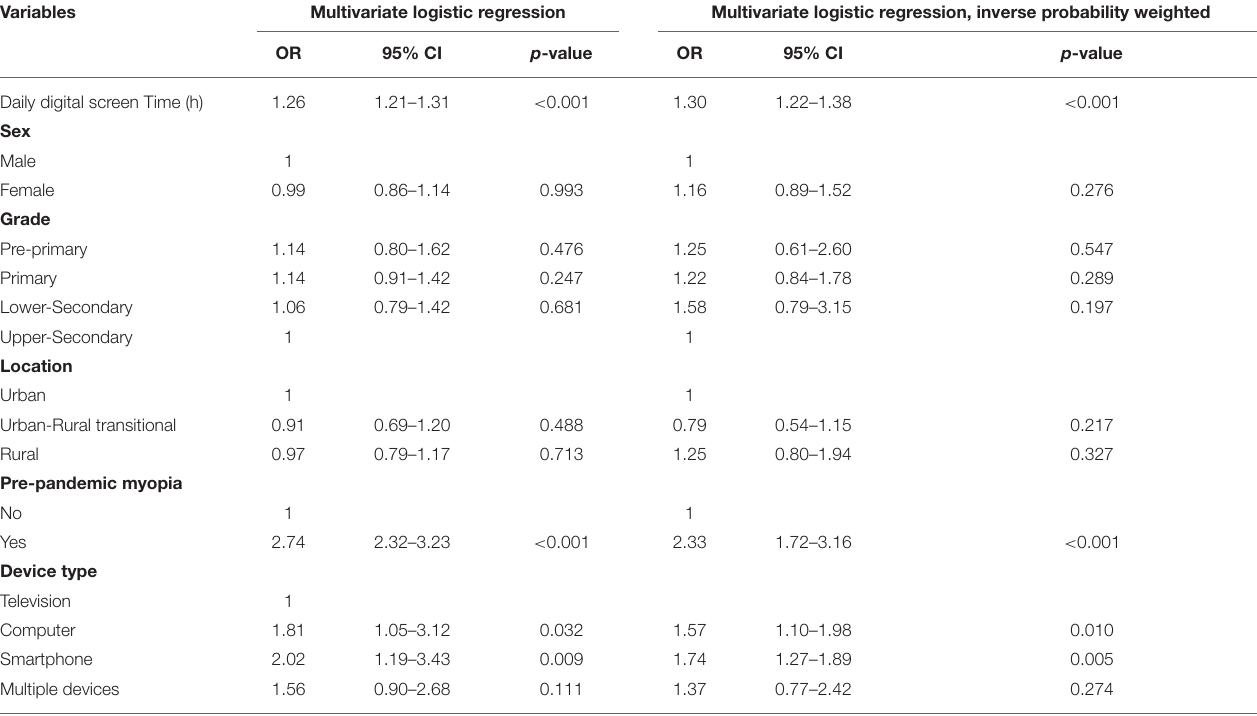
TABLE 2 | Binary multivariate logistic regression analysis on influencing factors of myopic progression ( N = 3,831).